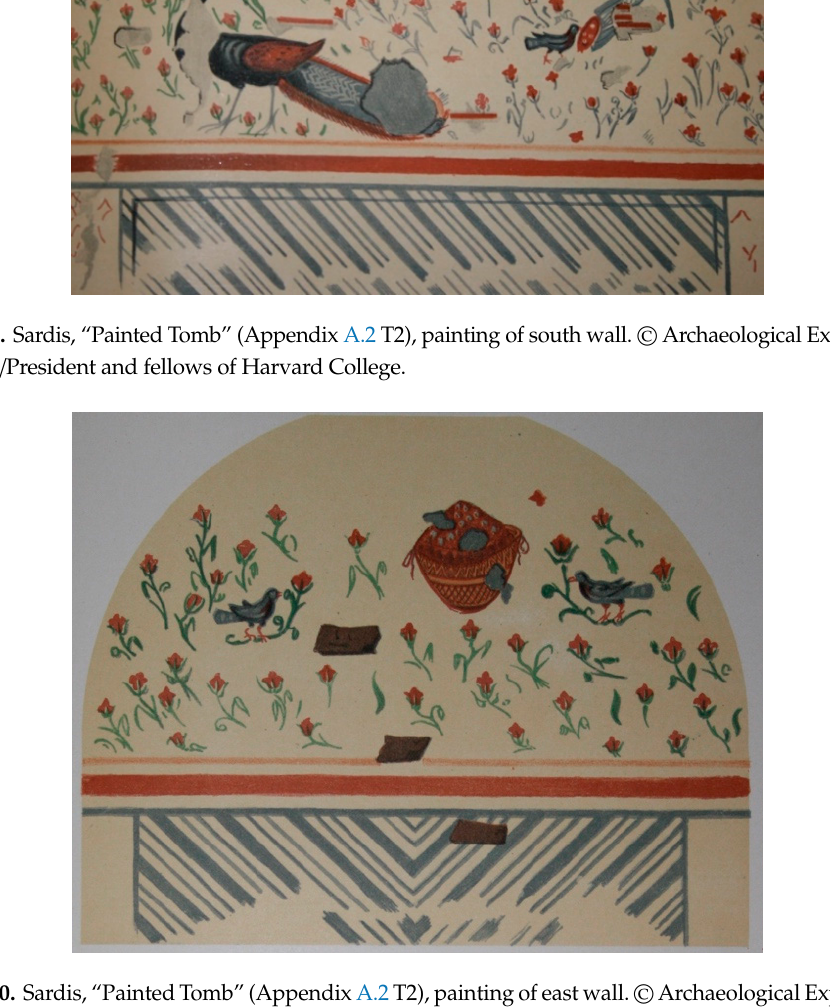
Figure 10. Sardis, “Painted Tomb” (Appendix A.2 T2), painting of east wall. © Archaeological Exploration of Sardis/President and fellows of Harvard College.